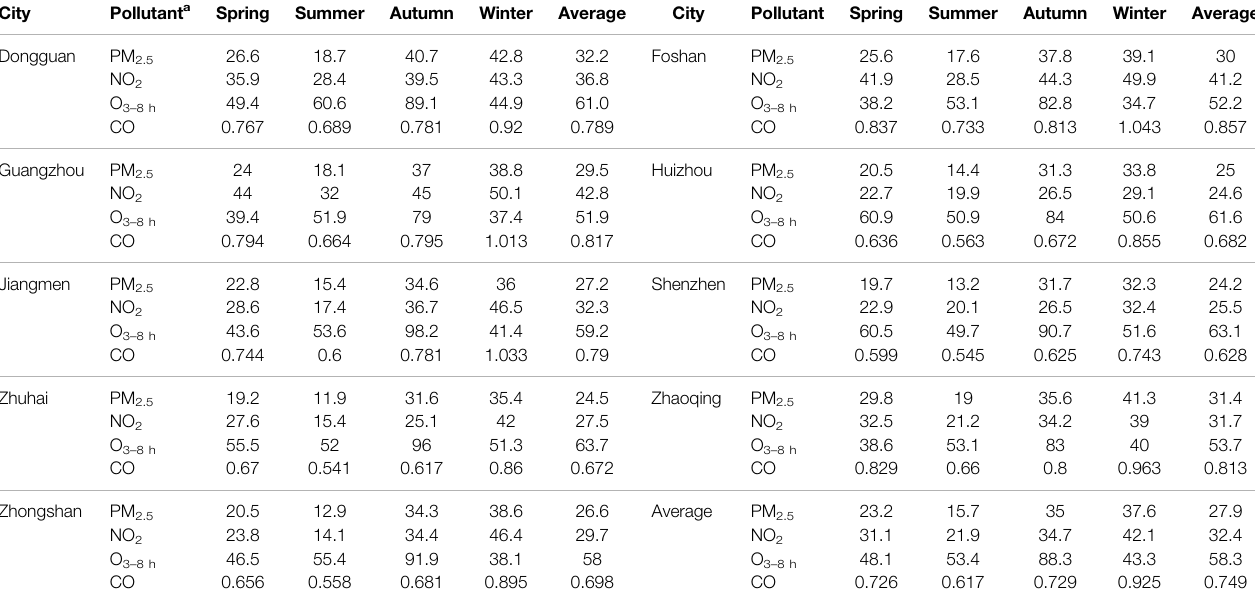
TABLE 1 | Seasonal variations of air pollutants in the